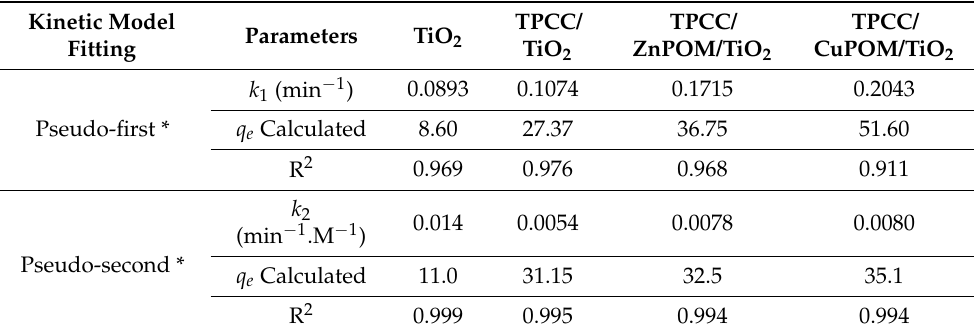
Table 4. Adsorption kinetic parameters using pseudo-first order, pseudo-second order and Elovich coefficient models.